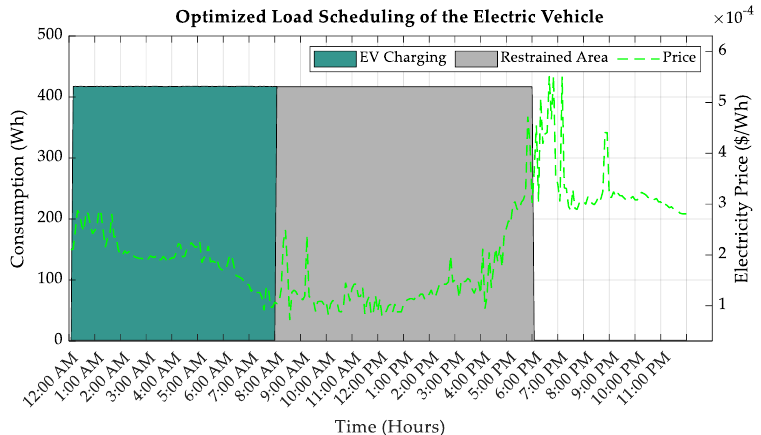
Figure 7. Load scheduling of the Charging of the EV under optimization for Price.